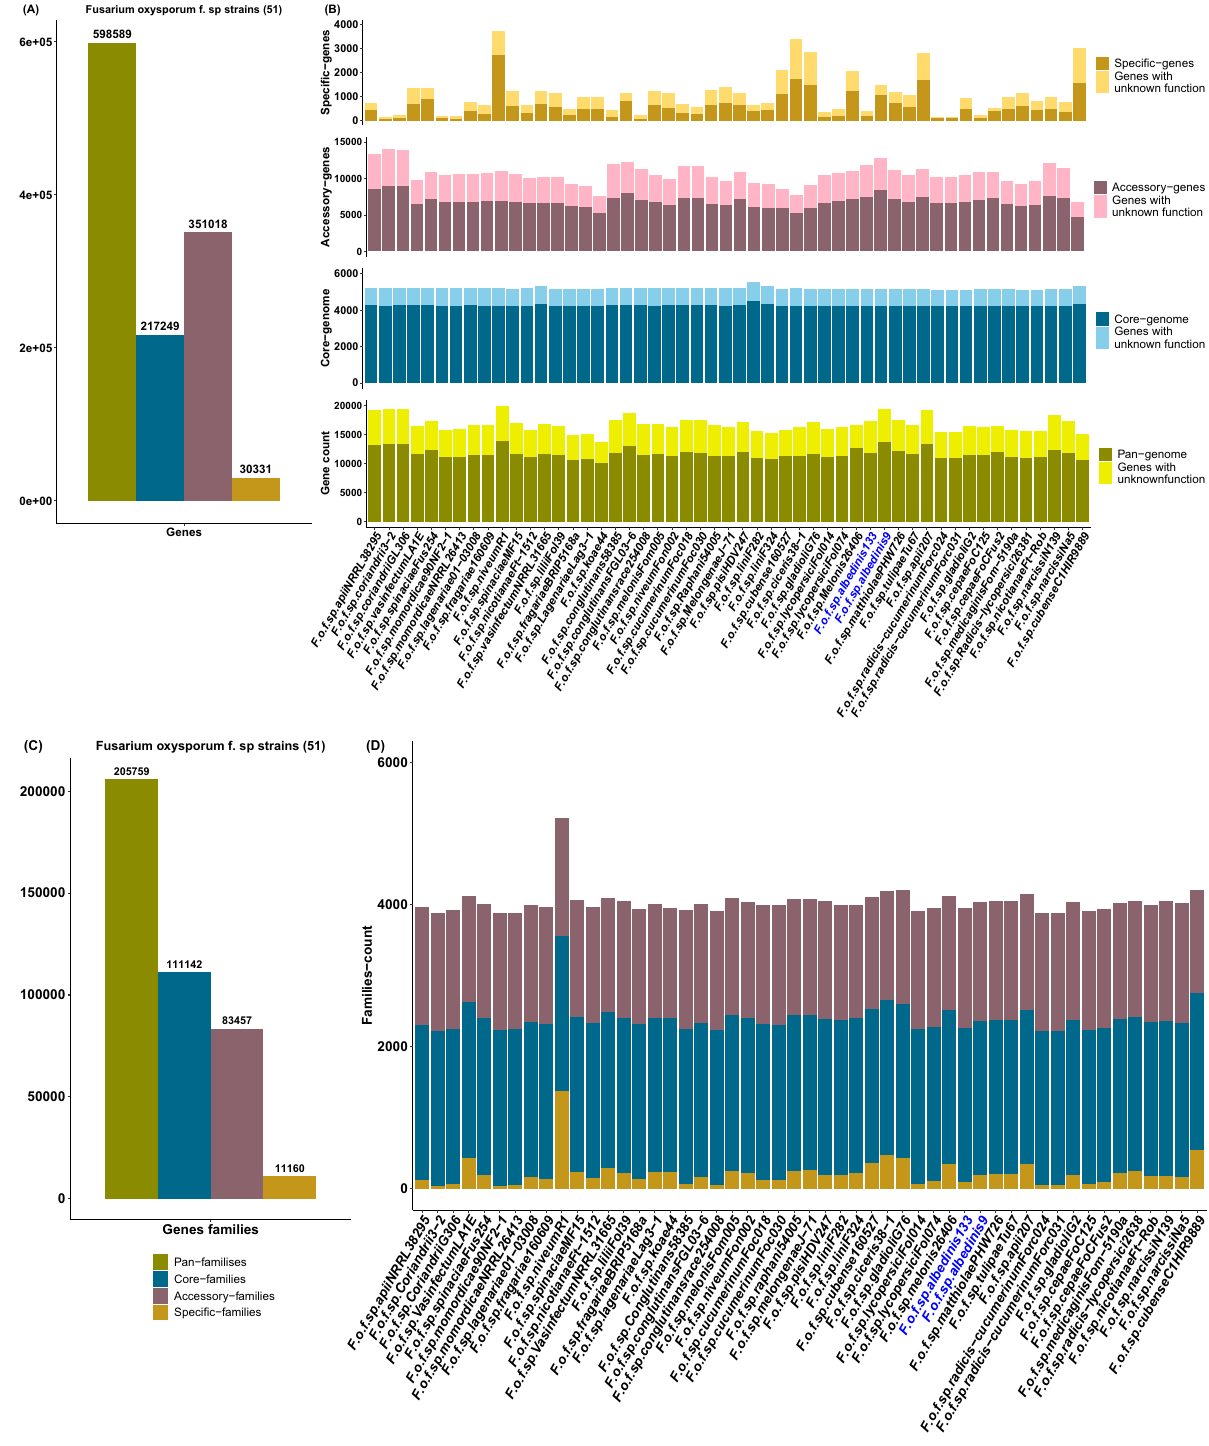
Figure 2. The pan-genome of the FOSC’s formae speciales including Foa. ( A , C ), histograms representing the total number of genes and families distributed over the pan-genome, core-genome, accessory-genome and unique-genome for the analyzed strains. ( B ), Stacked histograms of the gene numbers of the pan-genome, core- genome, accessory-genome and unique-genome for each strain. ( D ), Stacked histograms of the number of core- families, accessory-families and unique-families for each strain. Abbreviations: F ( Fusarium ); o ( oxysporum ); f ( forma e); sp (speciales ). The names following the abbreviations represent the names of the formae speciales ; the abbreviations coming after the names of the formae speciales correspond to the strains belonging to these formae speciales (F.o.f.sp. albedinis 133: Fusarium osysporum forma specialis albedinis Foa